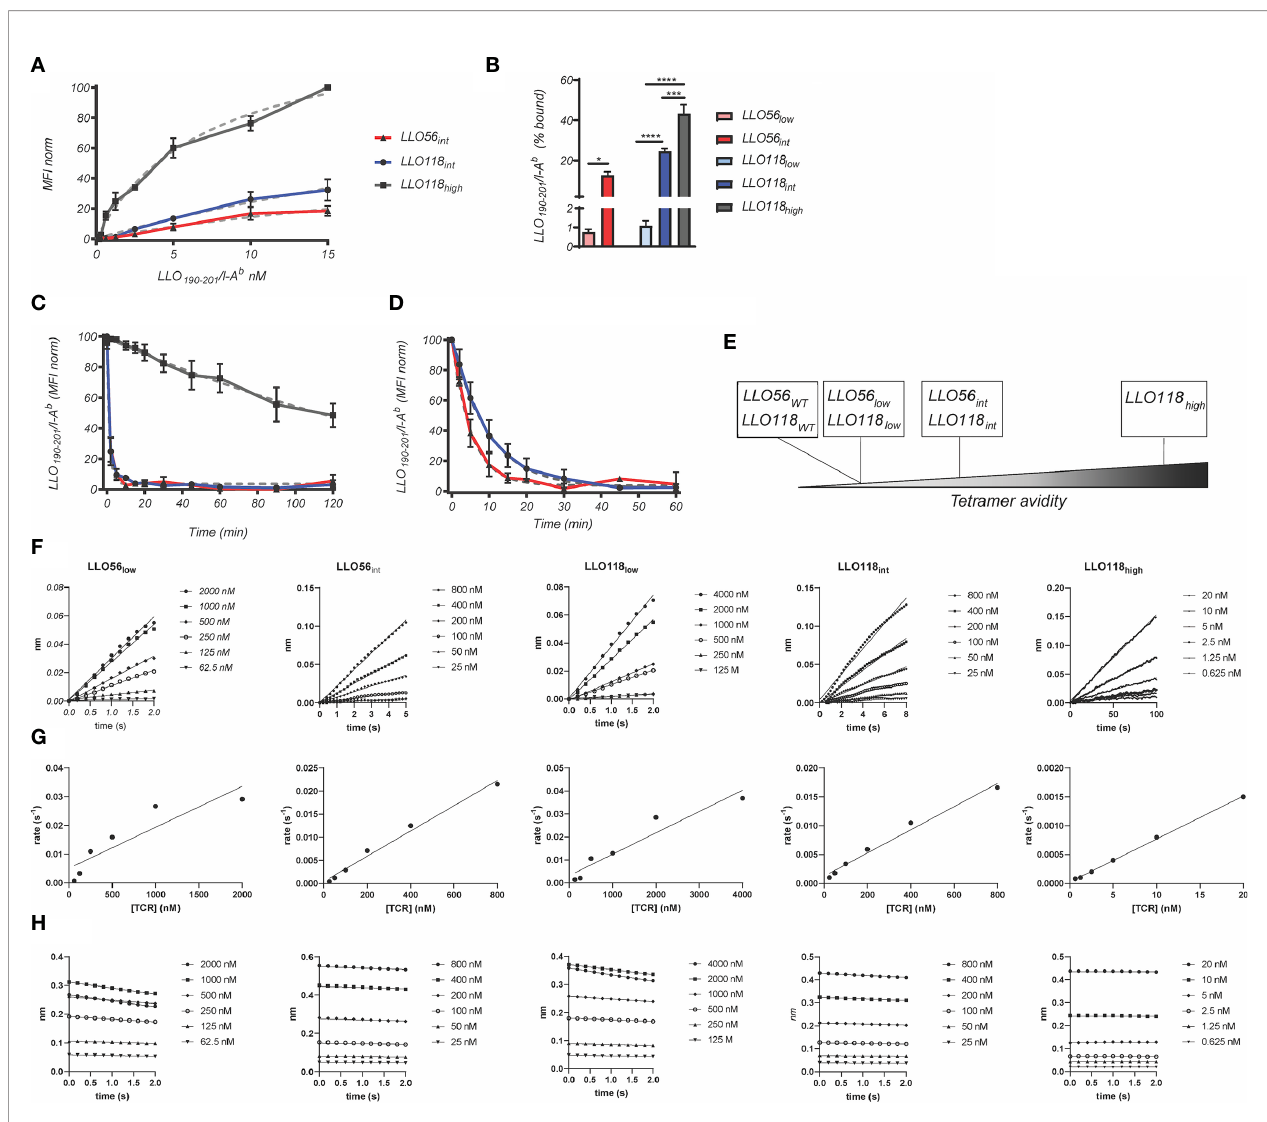
FIGURE 2 | Avidity and af fi nity measurements of scTCRs. (A) To estimate avidity K D , af fi nity clones presented by yeast were incubated with various concentrations of LLO 190-201 /I-A b tetramer (1.52 – 50 nM) and 50,000 events were collected via fl ow cytometry. Grey dotted lines represent non-linear, one site-speci fi c binding analysis of tetramer binding measurements used to estimate K D for LLO56 int (red), LLO118 int (blue), and LLO118 high (dark grey) (n = 3 experiments). (B) Percent of cells bound by tetramer for each af fi nity clone. LLO56 low had signi fi cantly lower binding than LLO56 int (0.75 ± 0.3% to 12.6 ± 3.4%, p = 0.0193) while LLO118 low (1.1 ± 0.5%) was signi fi cantly lower than LLO118 int (24.5 ± 2.9%) and LLO118 high (43.3 ± 8.9%) (p < 0.0001 and p < 0.0001, respectively) and LLO118 int was signi fi cantly lower than LLO118 high (p = 0.0004). To determine t 1/2 , yeast displayed af fi nity clones were incubated with (C) 1 M and (D) 0.1 M LLO 190-201 /I-A b tetramer. Following an initial measurement, 1.0 µg/ml anti-mouse MHC class II (I-A, I-E) monoclonal antibody was added and tetramer binding measured at each time point by fl ow cytometry. t 1/2 was estimated as the time it took to reach 50% MFI modeled by non-linear dissociation one phase exponential decay (dotted light grey lines) (n = 3 experiments). (E) A graphical depiction of range of af fi nity clones. To estimate TCR af fi nity, scTCRs were secreted by E . coli , chemically refolded, and incubated with streptavidin sensors loaded with biotinylated LLO 190-201 /I-A b monomer using BLI. No binding was observed between scTCRs and streptavidin biosensors in the absence of LLO 190-201 /I-A b loading (n = 3 – 6 independent measurements). (F) k obs is the linear slope of nm vs time. (G) k assoc is the linear slope of k obs vs scTCR concentration. (H) k diss is the exponential slope of dissociation nm vs time. *<0.05, ***<0.001,